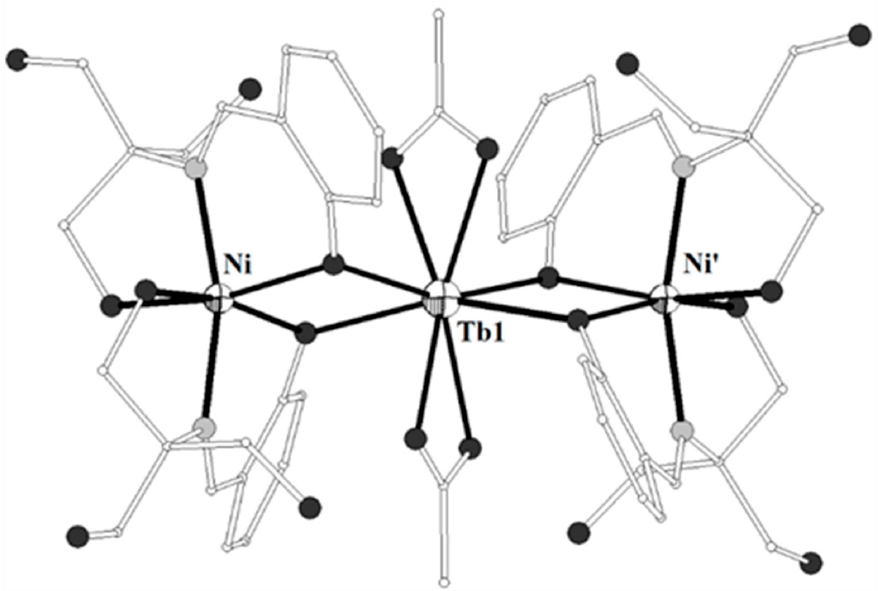
Figure 8. The molecular structure of the cation [{Ni(H 3 L 14 ) 2 } 2 Ln(O 2 CMe) 2 ] + in complex 83 . Primed atoms are generated by symmetry: (‘) 1.5 − x , 0.5 − y , z . Color code as in Figure 2 [34]. The diylbis(azanylylidene))bis(methanylylidene))bis(2-ethoxyphenol) (Scheme 2) gave two isostructural trinuclear complexes [(NiL 15 ) 2 Ln(NO 3 ) 2 ](NO 3 ) (Ln III = La, Ce, 84 – 85 ) with bent Ni-Ln-Ni arrangement